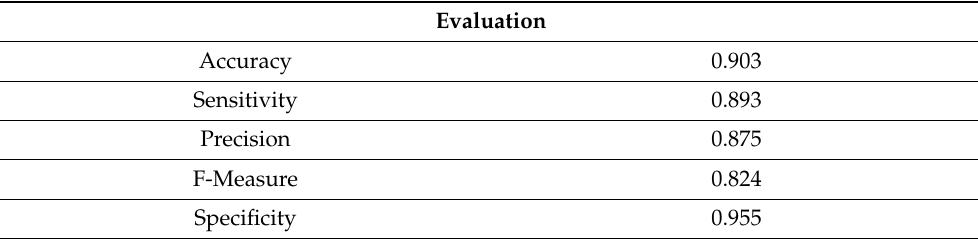
Table 10. Evaluation with accuracy, sensitivity, precision, F-measure and